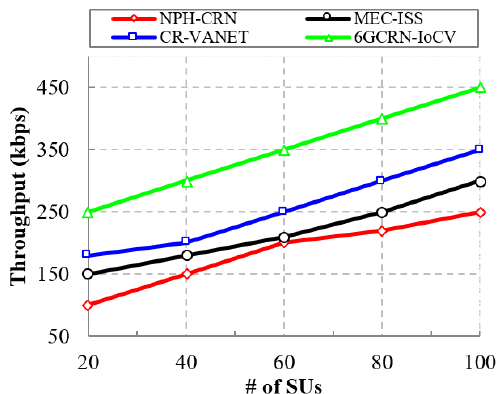
Figure 7. Throughput vs. the number of